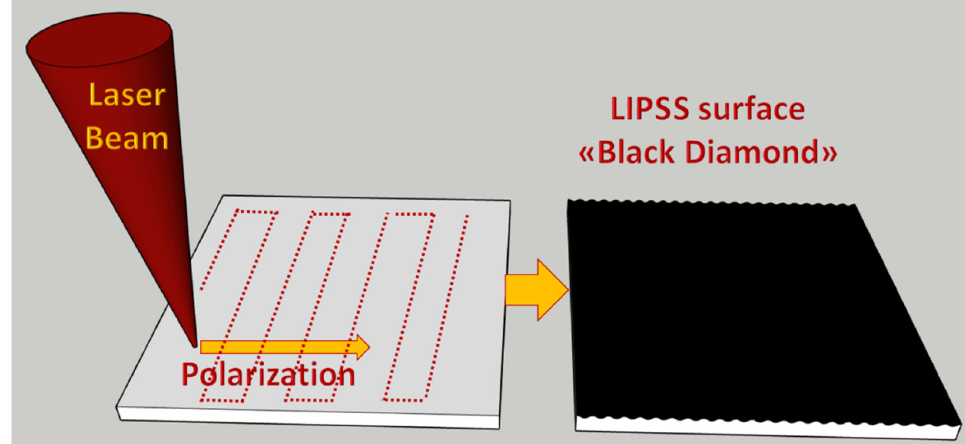
Figure 1. Schematic of the “Black Diamond” fabrication process.